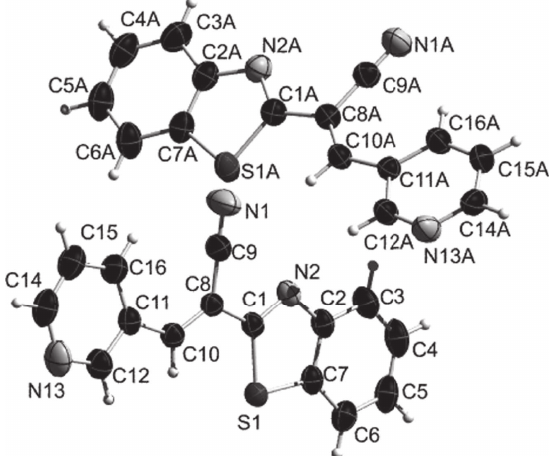
Table 2: Fractional atomic coordinates and isotropic or